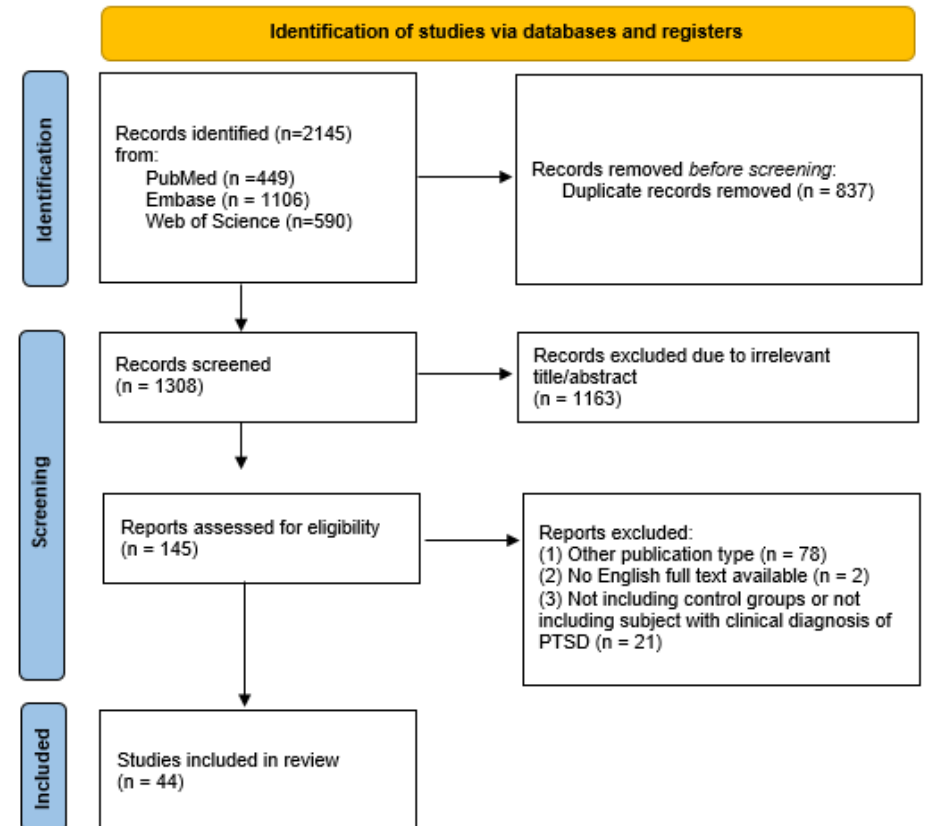
Figure 1. PRISMA flow diagram of the study selection process. PRISMA, Preferred Reporting Items for Systematic reviews and Meta-Analyses; PTSD, Post-Traumatic Stress Disorder.